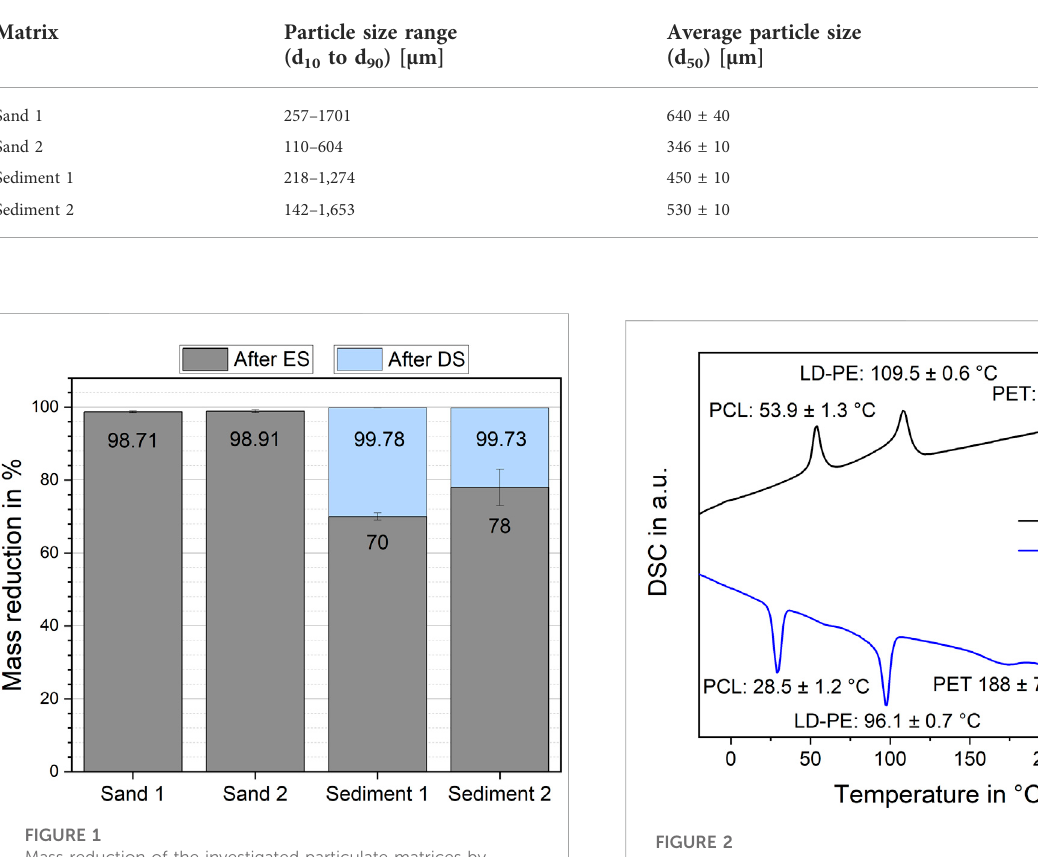
TABLE 3 Particle size distribution and TOC concentration of the four investigated matrices.